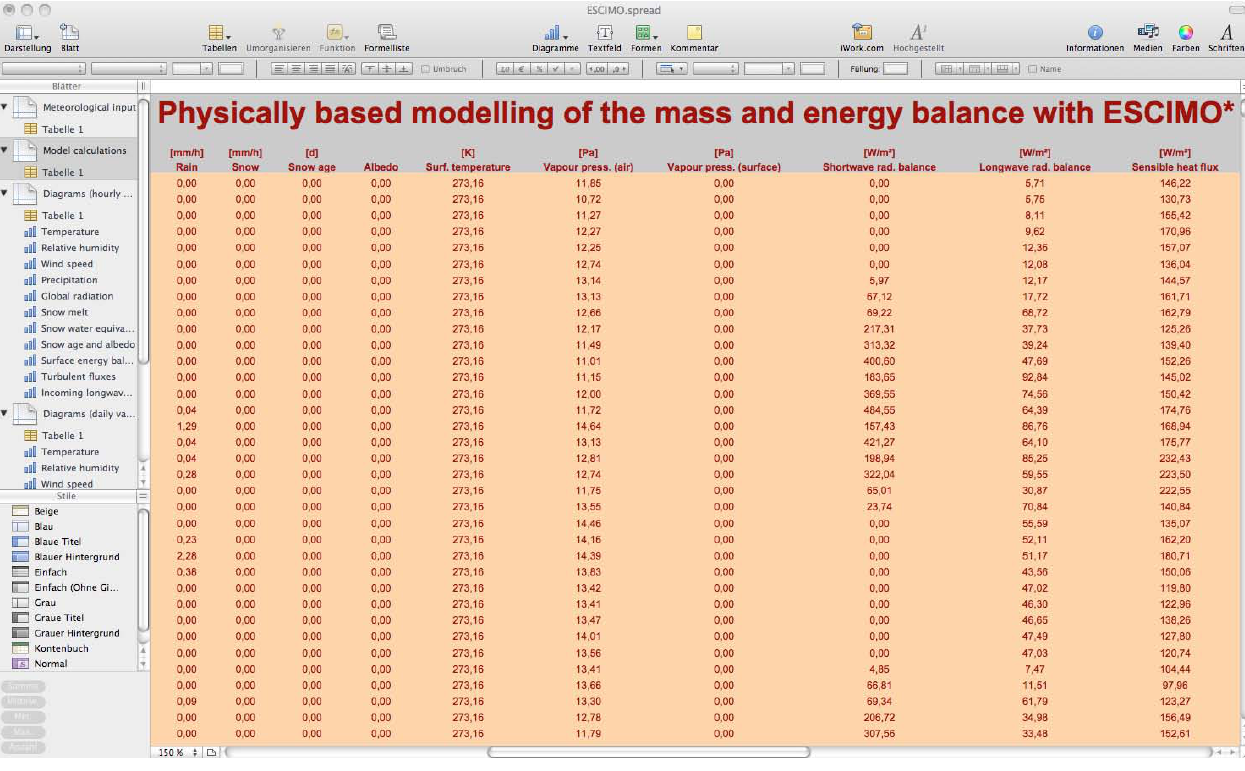
Fig. 2. Screenshot of the ESCIMO.spread spreadsheet in Apple